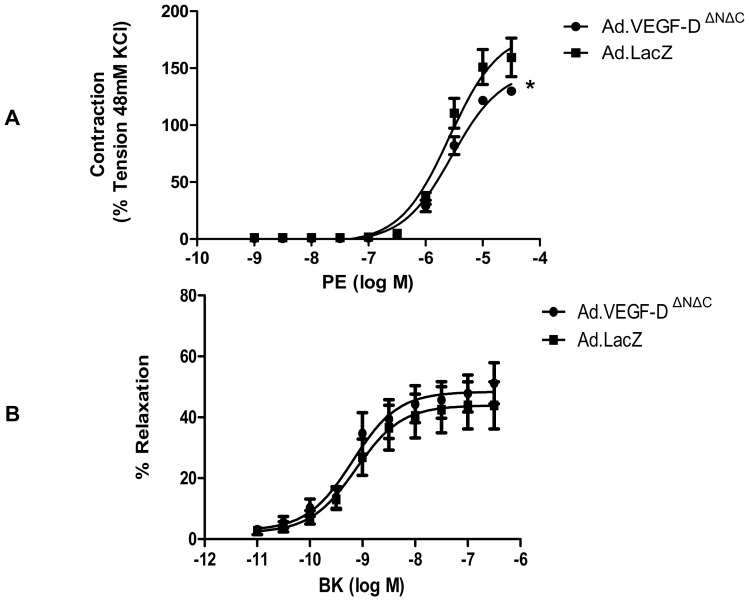
Vascular reactivity of uterine arteries 30–45 days after vector administration.(A) Logarithmic dose-response curve to L-phenylephrine (PE) depicting that the contractile tension generated in the UtAs of term pregnant sheep (n = 5) is significantly lower in Ad.VEGF-DΔNΔC transduced vessels relative to Ad.LacZ transduced vessels 30–45 days post-injection. The contractility of the vessel is expressed as a percentage of the response to KCl. * p<0.005. (B) Logarithmic dose-response curve to Bradykinin (BK) depicting that the relaxation response generated in the UtAs of term pregnant sheep (n = 5) is not significantly different between the Ad.VEGF-DΔNΔC and Ad.LacZ treated vessels 30–45 days post-injection. The relaxation is expressed as a percentage of inhibition of PE-induced contractions. Error bars denote SEM.